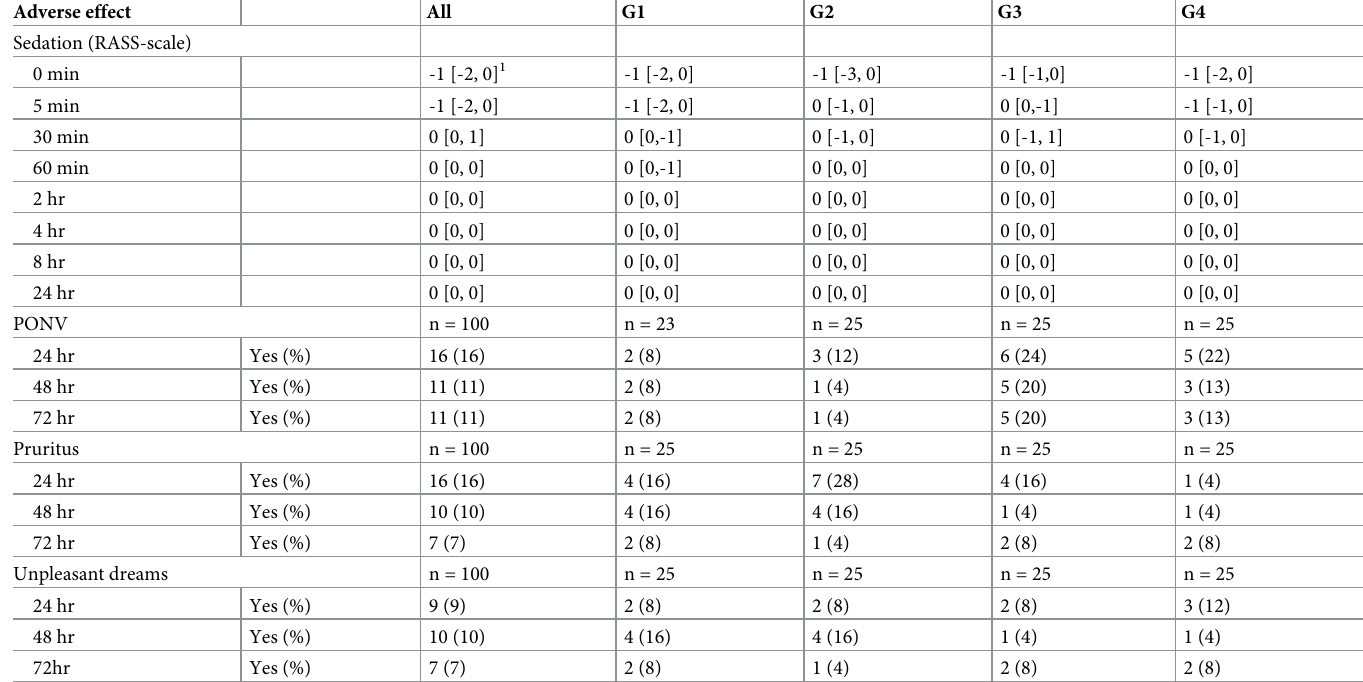
Table 4. Opioid related adverse events during the